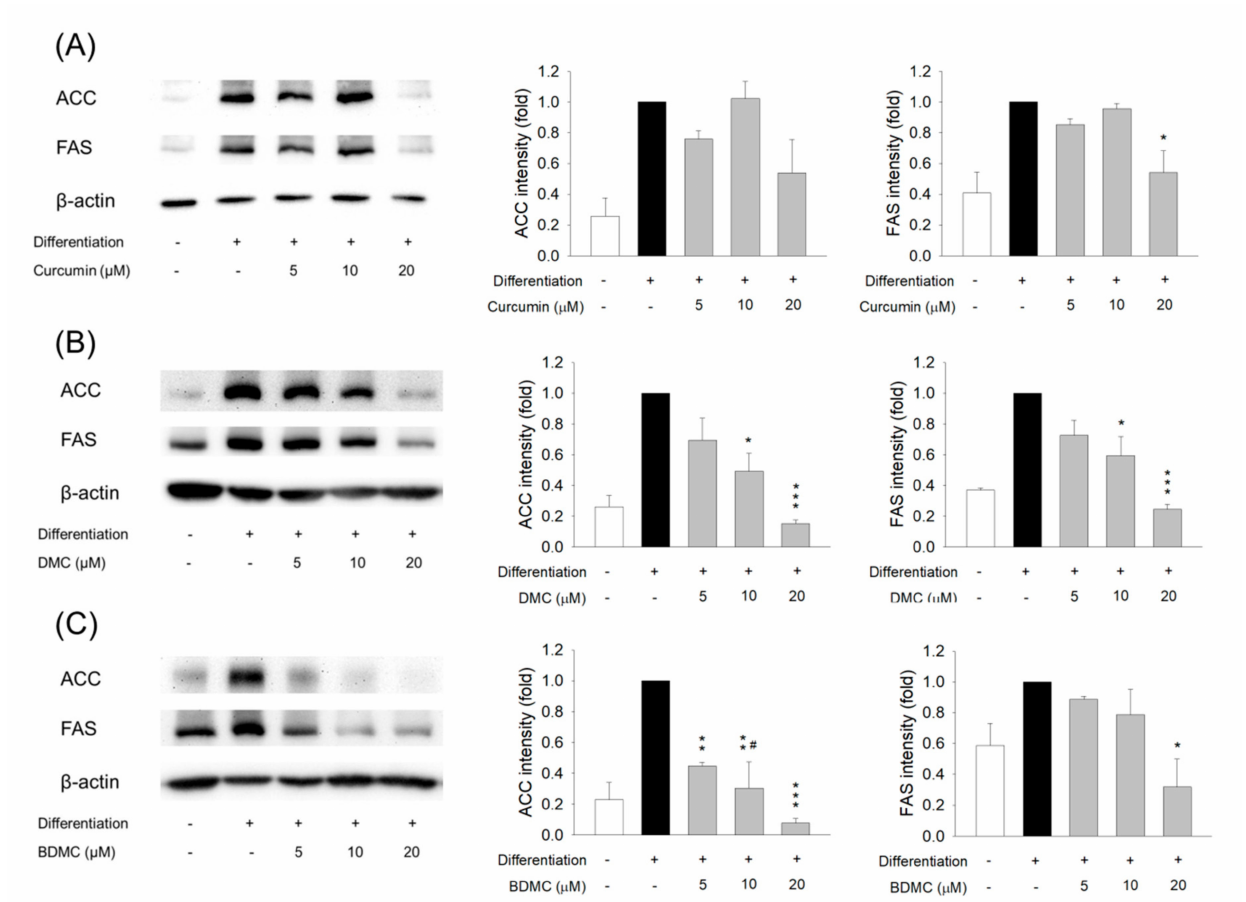
Figure 5. The effect of curcuminoids on lipogenic enzymes of 3T3-L1 cells. ( A ) The protein expression of ACC and FAS after treatment of curcumin at 0 − 20 µ M; ( B ) the protein expression of ACC and FAS after treatment of DMC at 0 − 20 µ M; and ( C ) the protein expression of ACC and FAS after treatment of BDMC at 0 − 20 µ M. All data are presented as the mean of three experiments ± S.E.M. *** p < 0.001; ** p < 0.01; * p < 0.05 as compared to the differentiated control group. # p < 0.05 as compared to the curcumin-treated group at the same